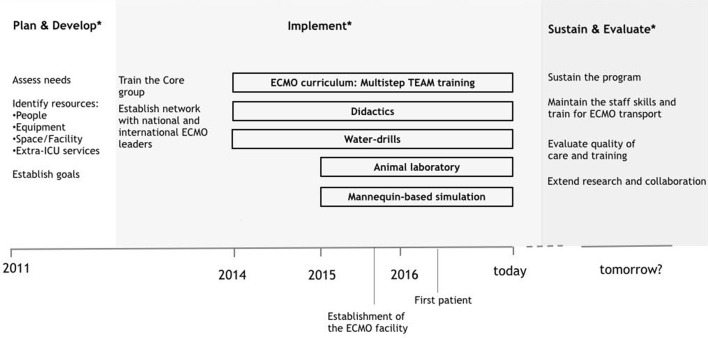
Development of a neonatal respiratory ECMO program: timeline of key steps. *The developmental process is based on ELSO guidelines (8, 16).